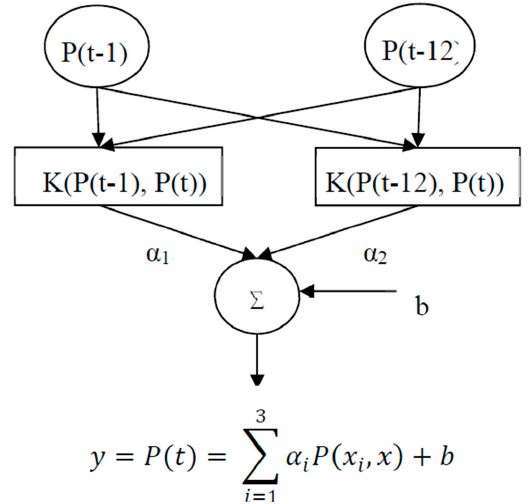
Figure 7. Structure of least square support vector machine (LSSVM).